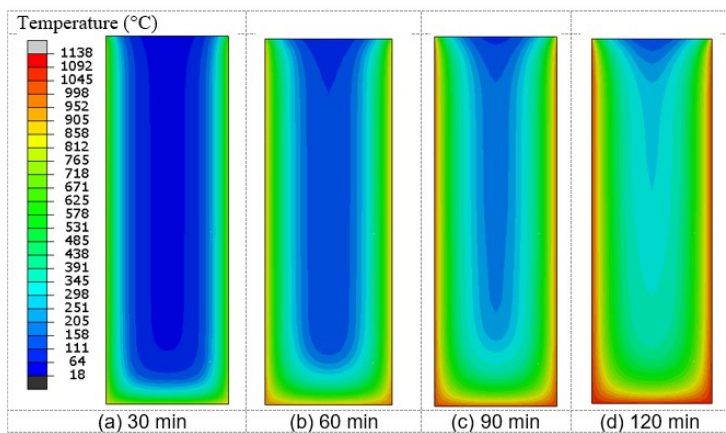
Figure 7 – Thermal field for different ISO 834 times (beam without